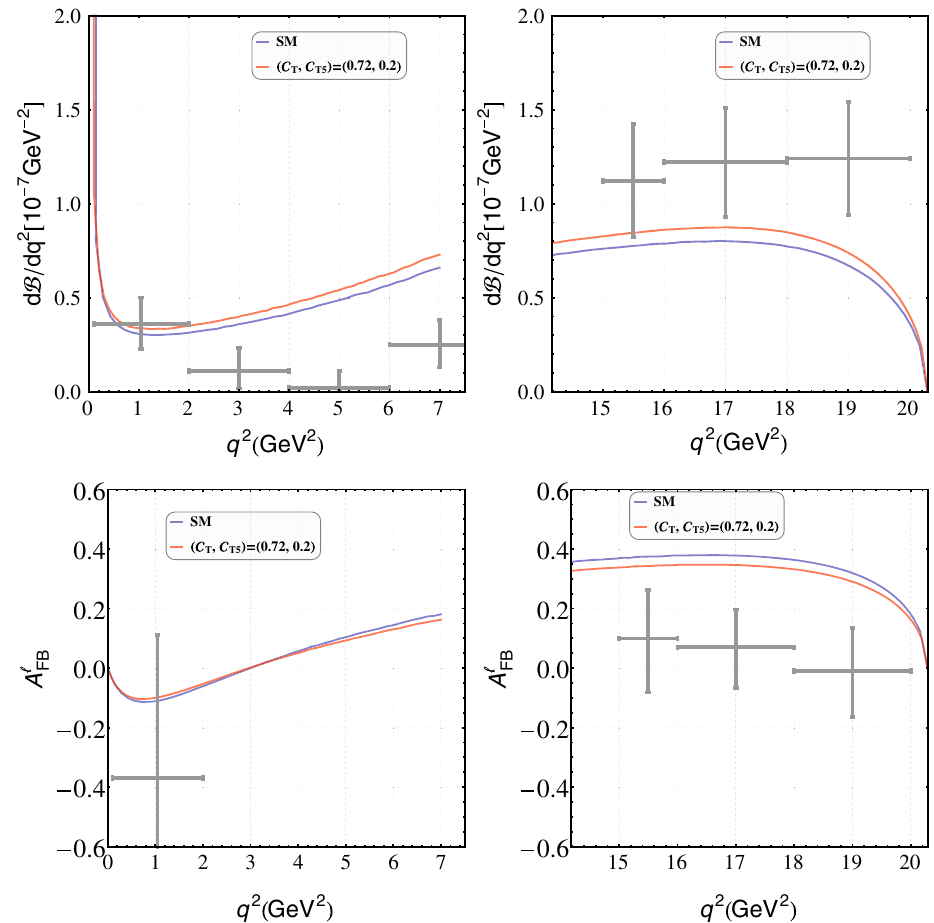
Fig. 4 The (cid:2) b → (cid:2)μ + μ − observables in the SM (blue) and for some new tensor couplings (shades of red). The points shown by cross marks indicate LHCb data